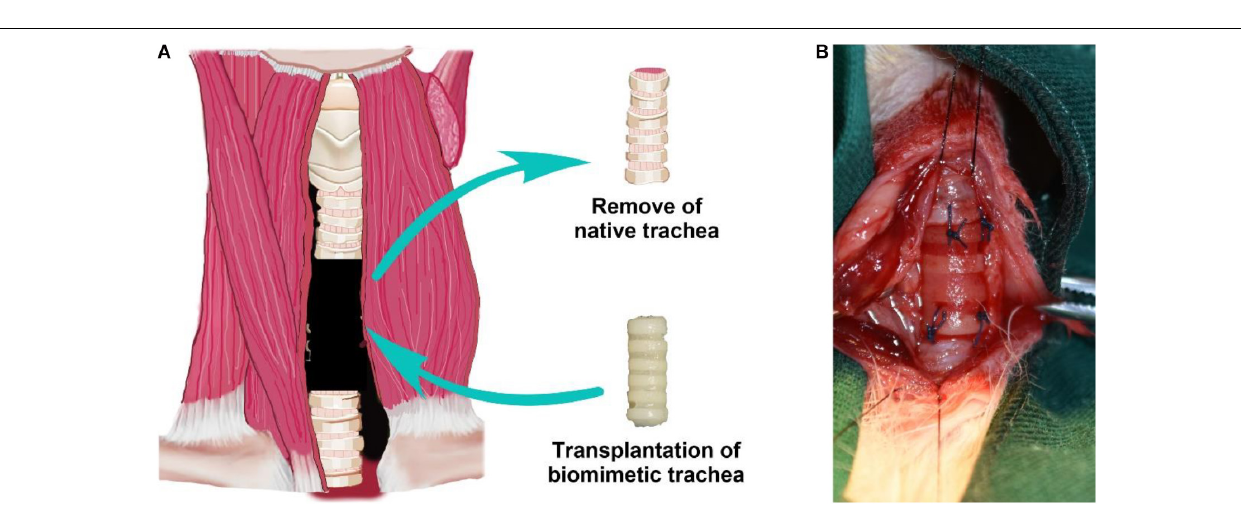
FIGURE 7 | Tracheal replacement using the biomimetic trachea. Schematic illustration of the replacement surgery (A) . Biomimetic trachea transplantation by end-to-end anastomosis (B)